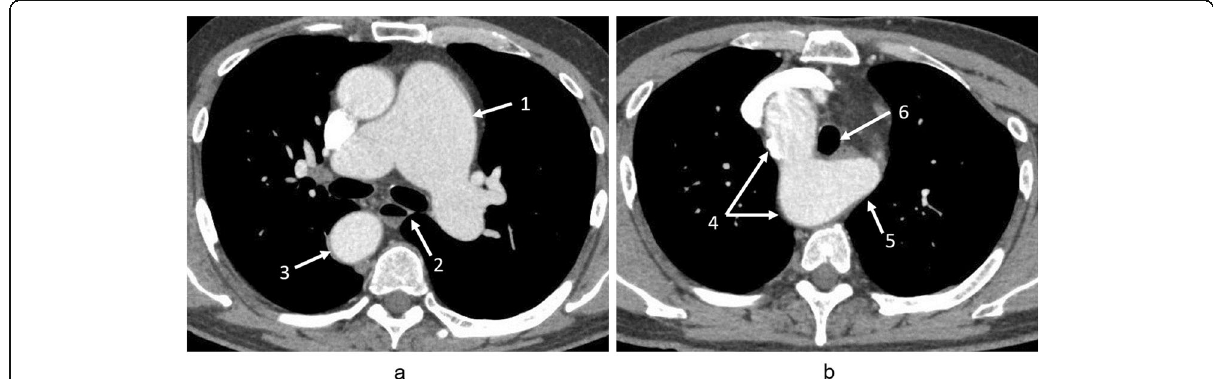
Fig. 1 a Contrast computed tomography showing a dilated pulmonary trunk. The dilated part of the pulmonary trunk (arrow 1) is not in contact with the sternum, nor does it displace the mediastinal tissues (arrow 2). The descending aorta is depicted in the right posterior mediastinum (arrow 3). b Arrow 4 indicates the right-sided aortic arch. The Kommerell ’ s diverticulum (3 cm) is depicted at the origin of the left subclavian artery (arrow 5). The trachea is slightly displaced by the diverticulum (arrow